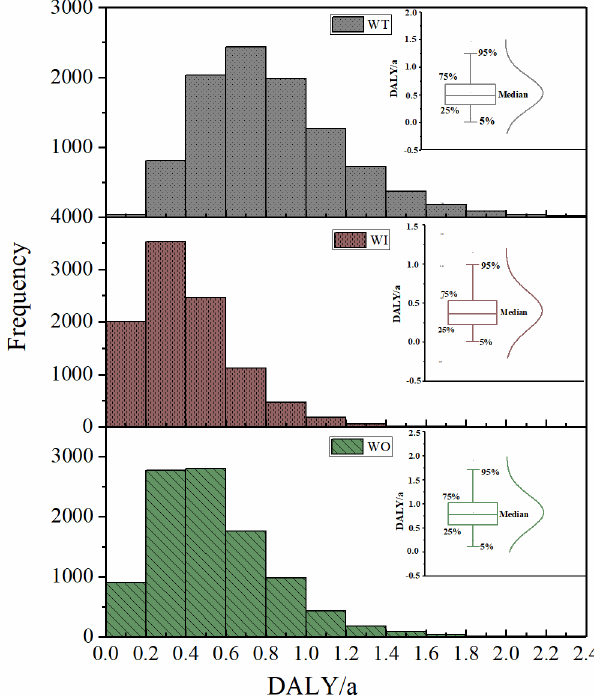
Figure 9. Wheat simulation results of the DALY